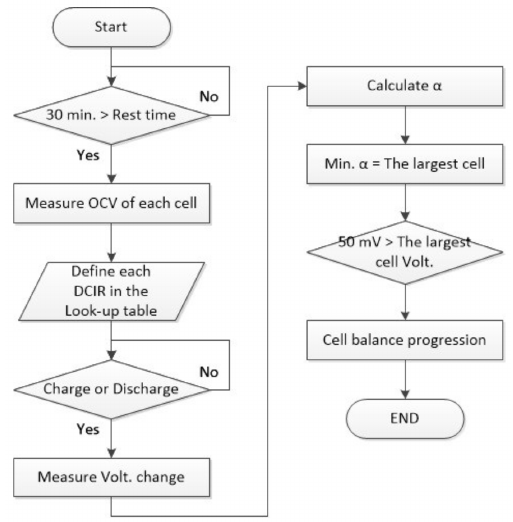
Figure 11. Proposed cell-balancing flow chart.